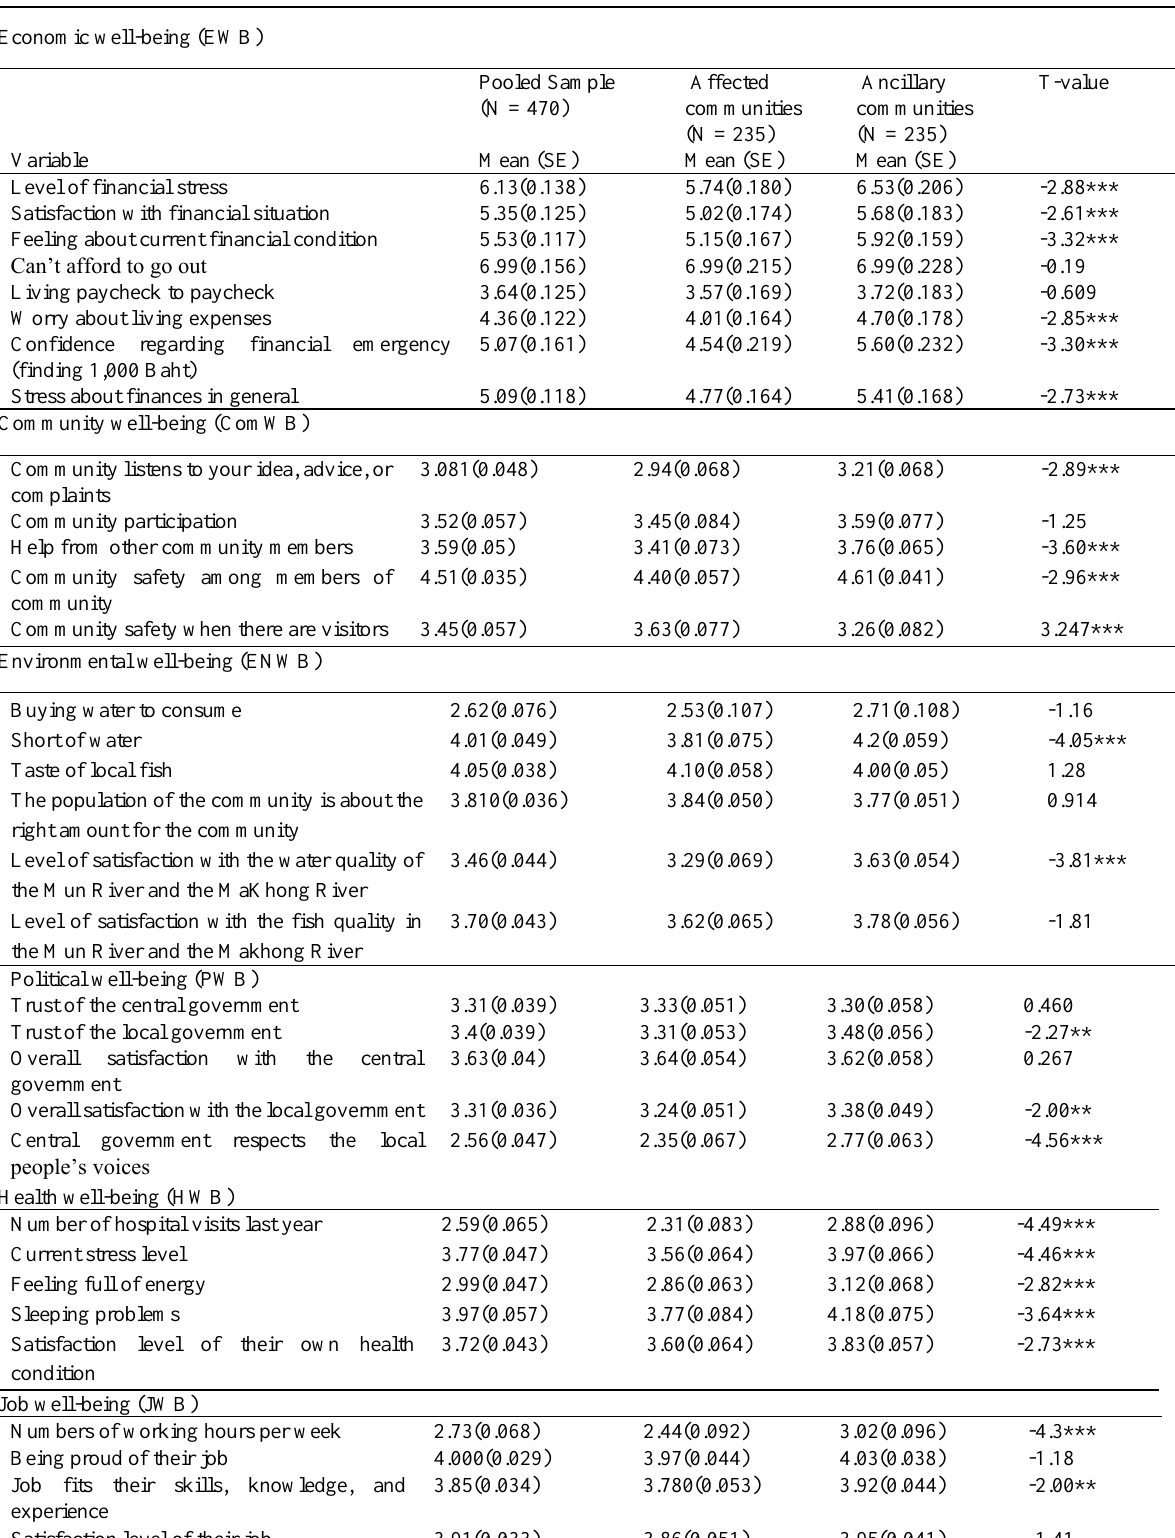
Table 6: Well-being Score and